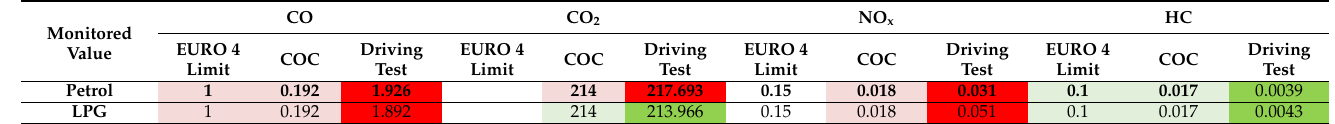
Table 5. Measured values of road emissions for CO, CO 2 , HC, and NO x in relation to Euro 4 and COC limits